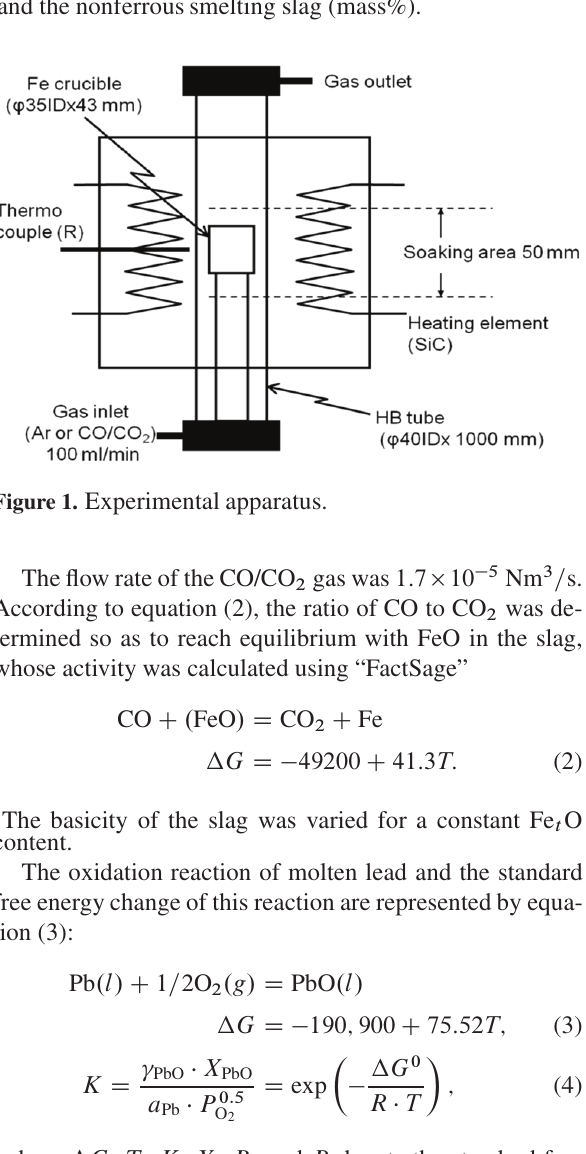
Table 1. Typical composition of the stainless steelmaking slag and the nonferrous smelting slag (mass%).